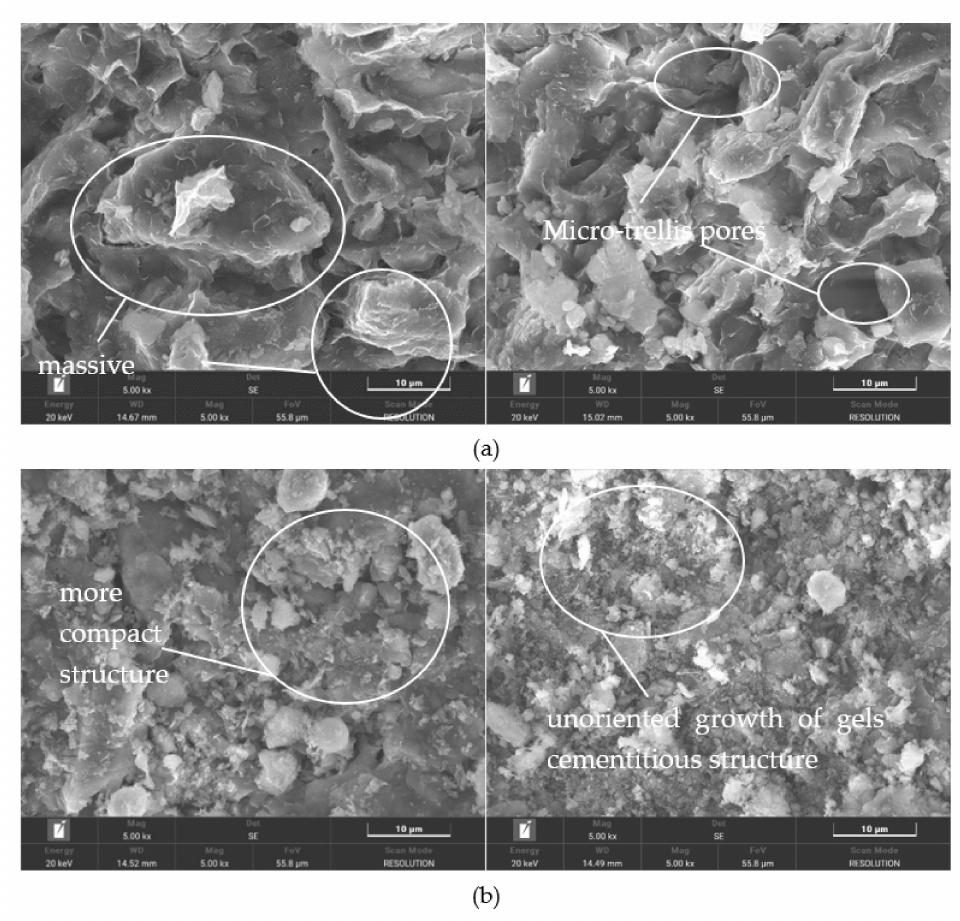
Figure 6. SEM images: ( a ) pure soil; ( b ) treated